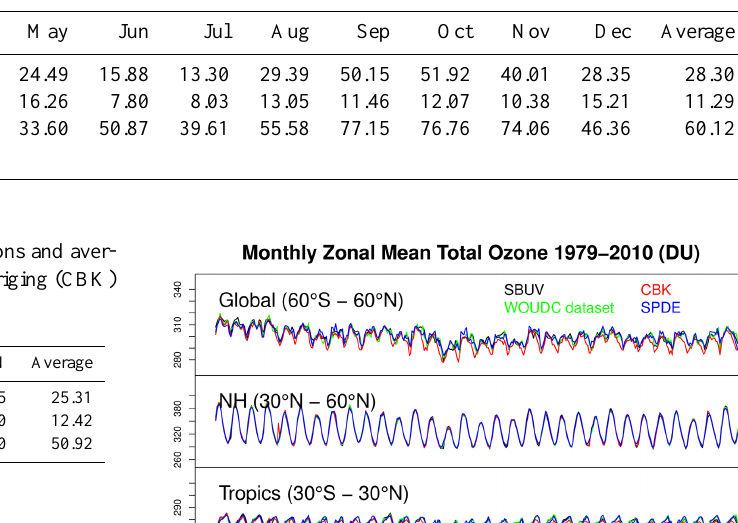
Table 5. Comparison with satellite data over all months and averaged over 2000–2005 RMSEs for covariance-based kriging (CBK) and SPDE predictions.